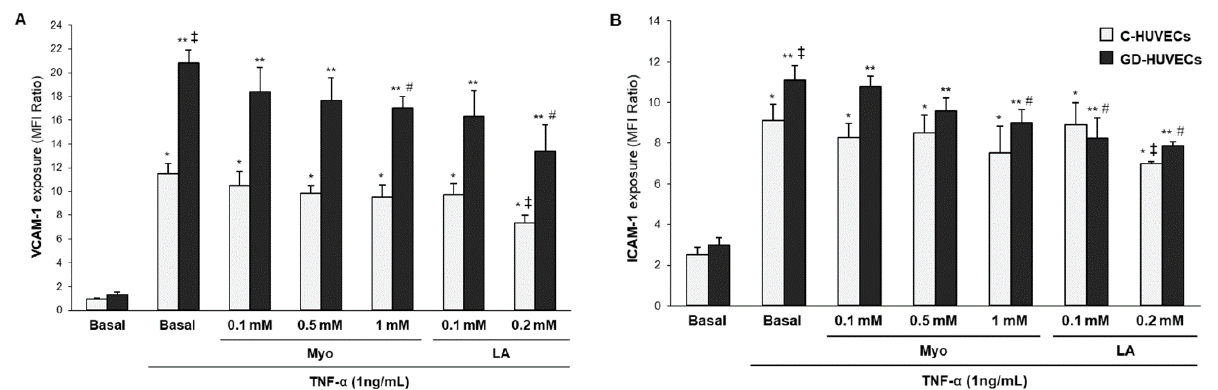
Figure 3. Effect of in vitro treatment with Myo on VCAM-1 ( A ) and ICAM-1 ( B ) membrane exposure after TNF- α -stimulation in C- and GD-HUVECs. * p < 0.001 vs. Basal C-HUVECs, ** p < 0.001 vs. Basal GD-HUVECs, ‡ p < 0.05 vs. TNF- α C-HUVECs, # p < 0.05 vs. TNF- α GD-HUVECs.